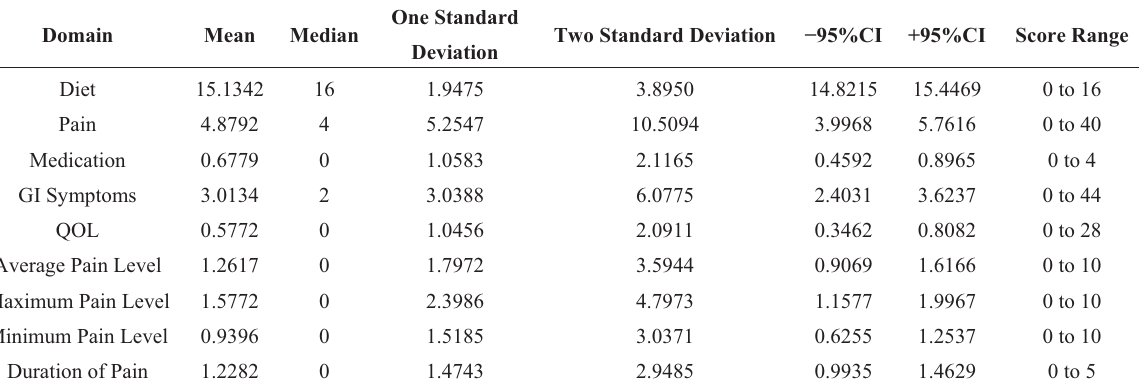
Table 3. Normal population basics statistics for the domains in the SBO QOL questionnaire. CI = confidence